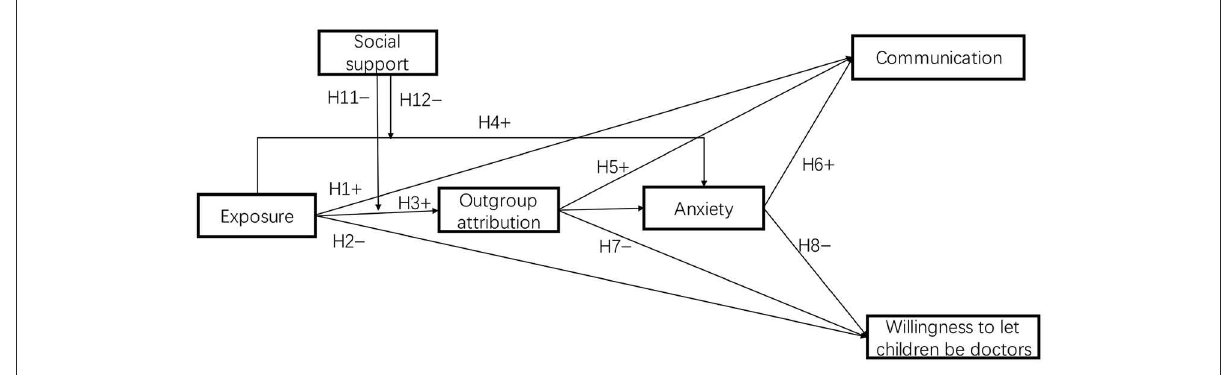
FIGURE1 Conceptual model.